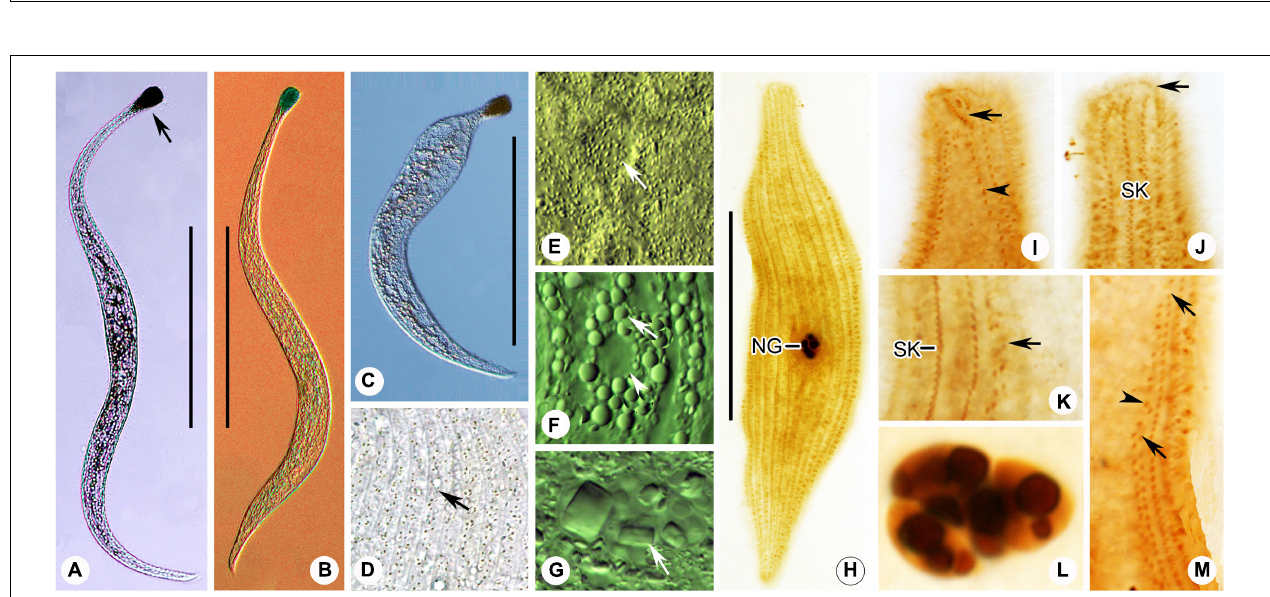
FIGURE 6 | (A–I) Tracheloraphis katzae spec. nov. in vivo (A–C,E) and after protargol staining (D,F–I) . (A–C) Typical individual. Arrow showing the head of the cell. (D) Ciliary pattern of bristle kinety (arrow) and somatic kinety. (E) Distribution of cortical granules (arrows) between somatic kineties. (F) Nuclear group. (G,H) Detailed ciliature of left (H) and right (G) side of anterior body region. Arrowhead in (H) showing brosse, arrow showing circumoral kinety, double arrowheads showing bristle kinety. Arrowhead in (G) showing circumoral kinety. (I) Right view of the holotype specimen showing the ciliary pattern, arrow depicts circumoral kinety. GS, glabrous stripe; SK, somatic kineties. Scale bars = 200 µ m (A–C) ; 70 µ m (I) .